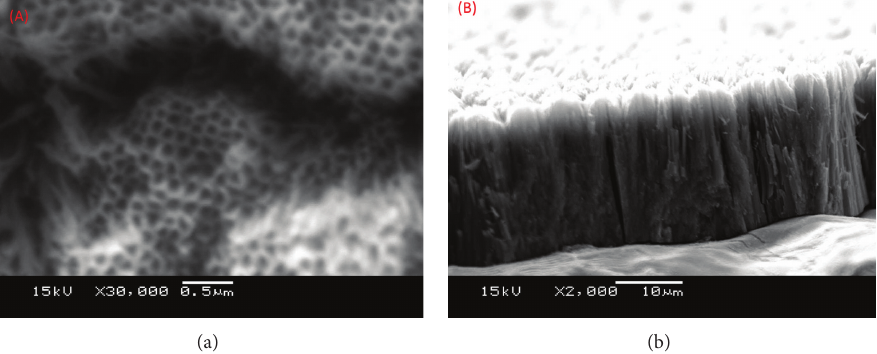
Figure 9: Morphologies of the TiO 2 nanotube arrays grown on chemical etching Ti plates (a) top view and (b) side view.